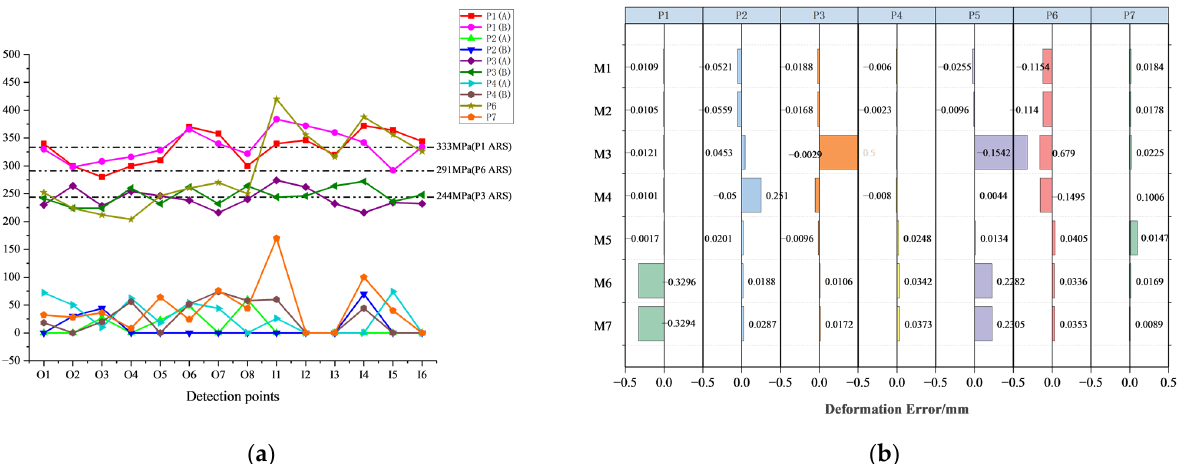
Figure 9. Residual stress distribution and deformation of 7# under different processes: ( a ) Residual stress; ( b ) Deformation.